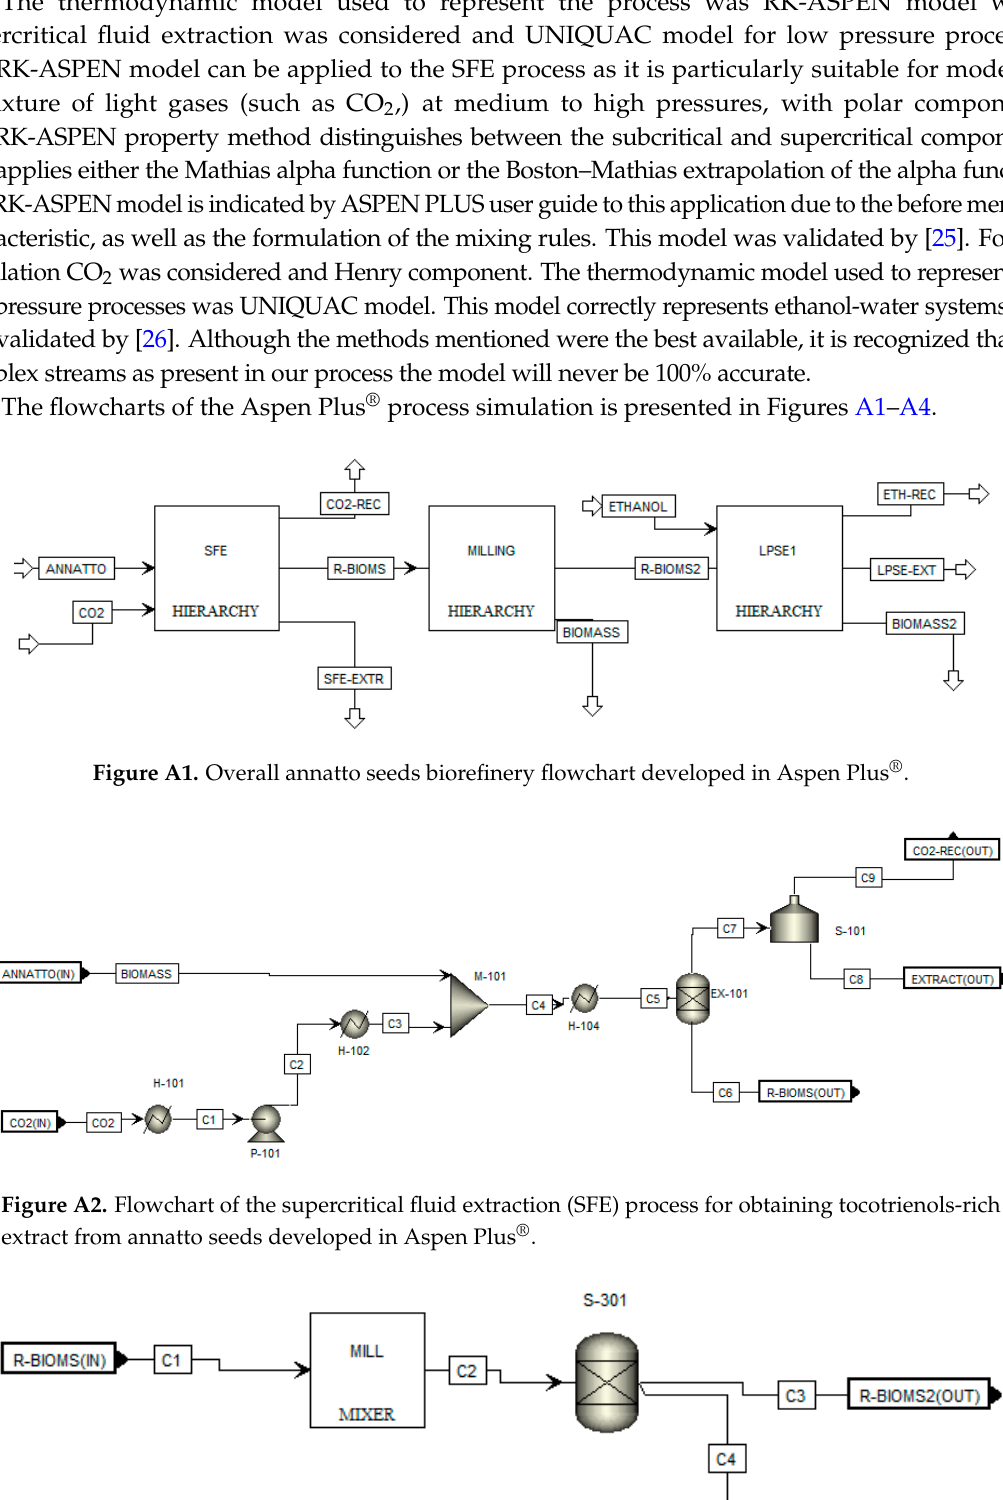
Figure A3. Flowchart of the fine particles separations process developed in Aspen Plus ® .